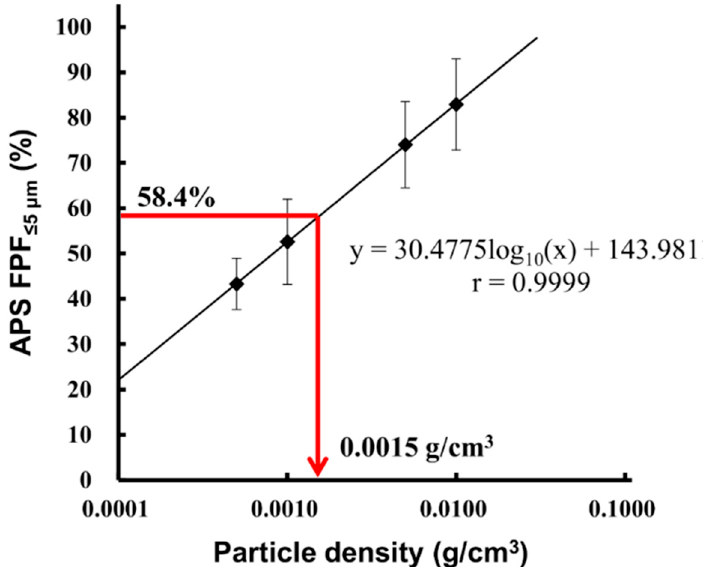
Figure 6. Particle density on inhalation of placebo (Phe 0.2 mg/vial). APS FPF% ≤ 5 µm of the placebo was calculated with the particle density changed in the range of 0.0005–0.01 g/cm 3 (mean ± S.E., n = 3) and plotted against the particle density. The particle density at which APS FPF% ≤ 5 µm value equaled that of MSLI FPF% ≤ 5 µm (58.4%) was calculated as 0.0015 g/cm 3 . Red arrow showed the particle density when APS FPF% ≤ 5 µm value was 58.4%. APS, aerodynamic particle sizer; FPF, fine particle fraction; MSLI, multi-stage liquid impinger. Table 2. Particle density calculated by conversion factor (3.75).